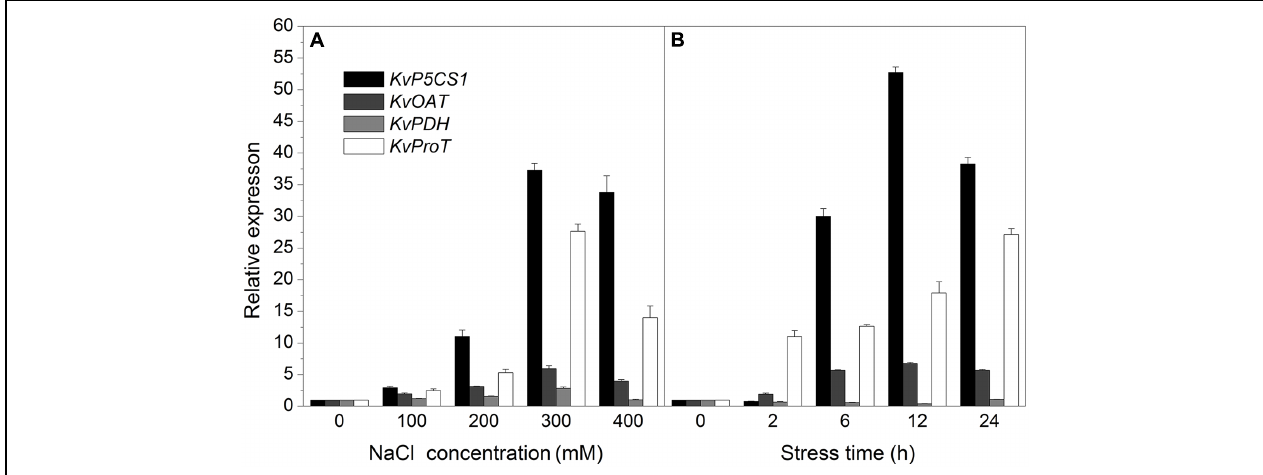
FIGURE 3 | The expression analysis of KvP5CS1 , KvOAT , KvPDH , and KvProT in leaves of Kosteletzkya virginica under salt stress. (A) Salt concentration gradient treatments; (B) Time-course treatments. Each data point represents the average of three replications and the error bars represents standard deviation based on three